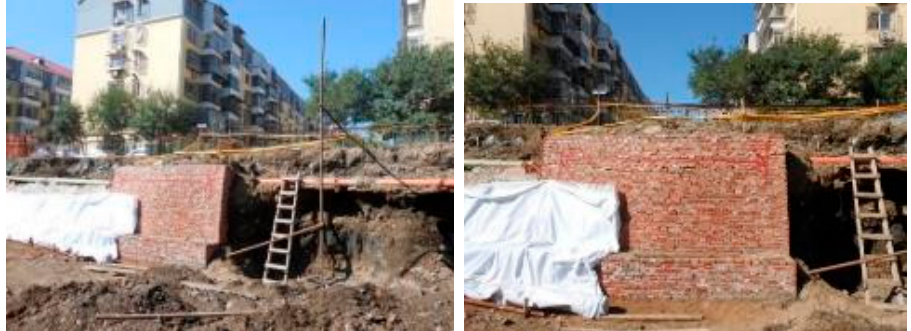
Figure 31. Buried gas pipeline in the city.